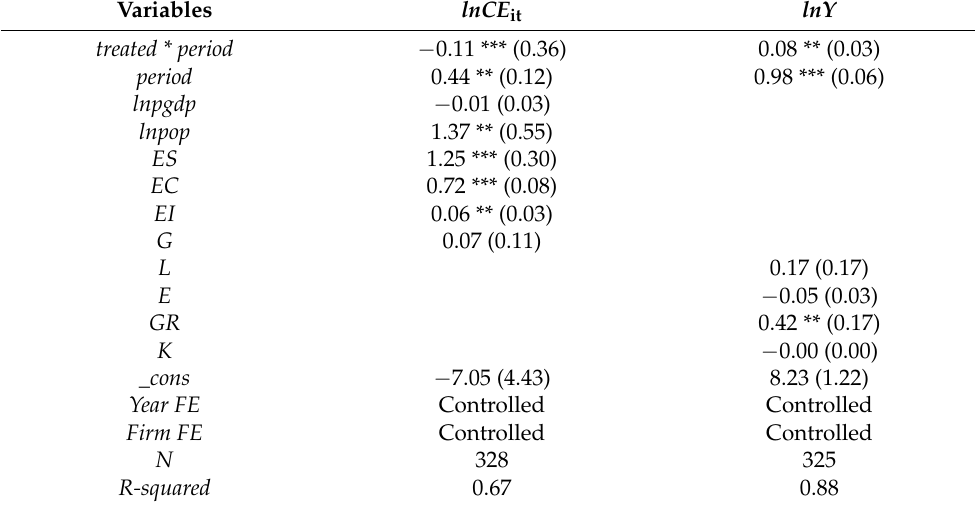
Table 2. DID regression